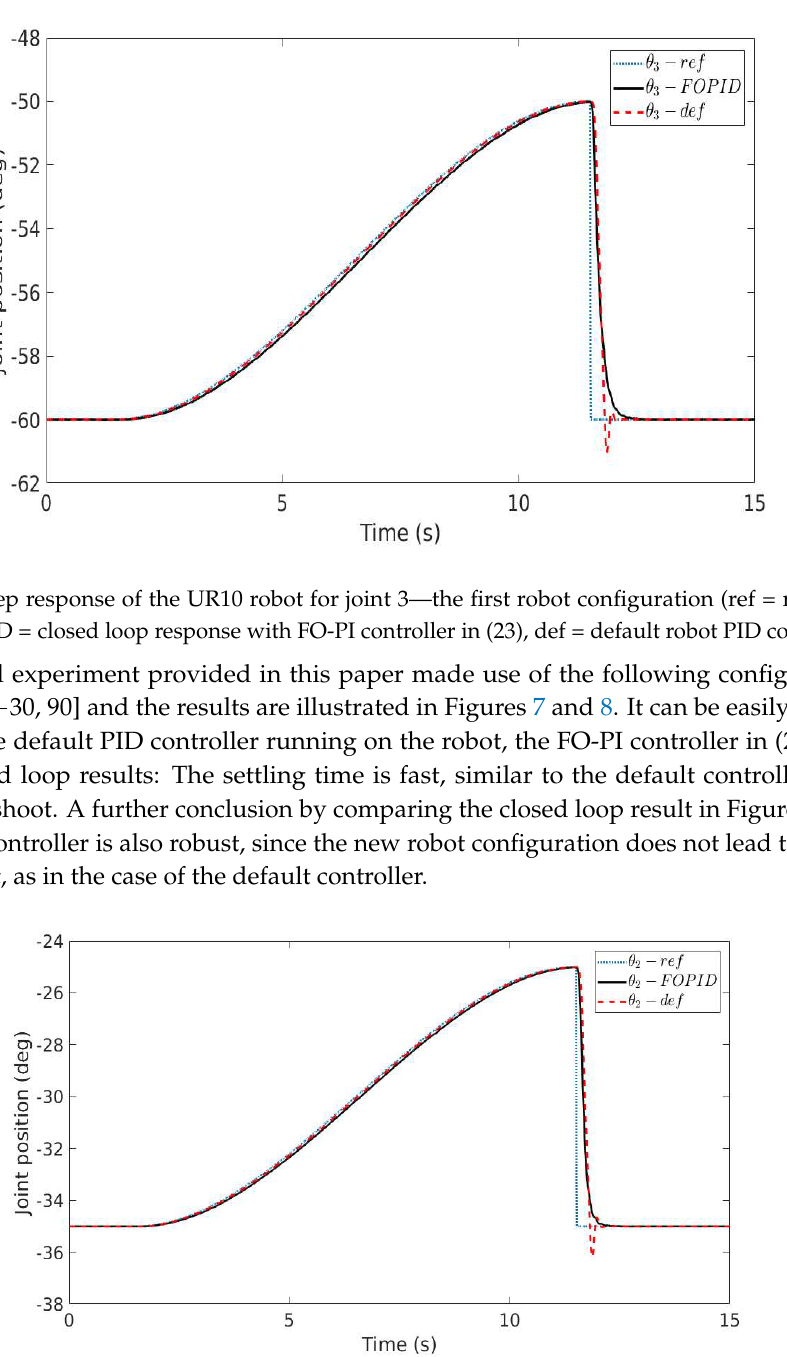
Figure 4. Frequency response of the FO-PI controller and its discrete-time approximation.